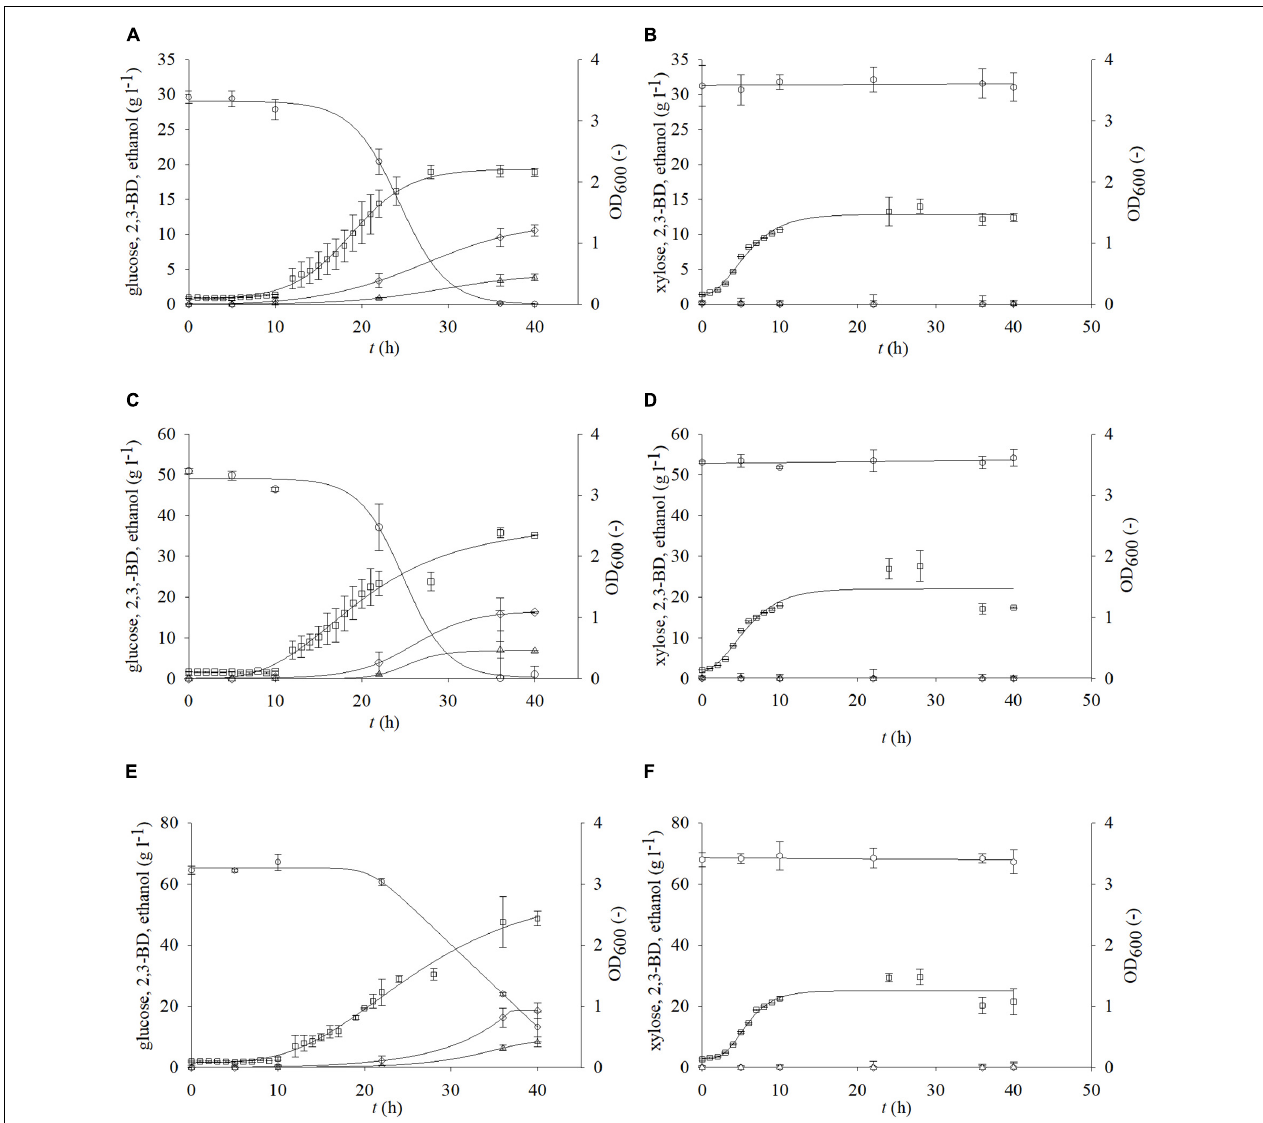
FIGURE 2 | Changes in optical density (OD 600 , (cid:3) ) and concentration of glucose ( (cid:13) ) or xylose ( ), 2,3-BD ( (cid:5) ), and ethanol ( (cid:52) ) during cultivation of bacterium P. polymyxa DSM 742 in media with different carbon sources and their concentrations ( A,C,E – glucose; B,D,F